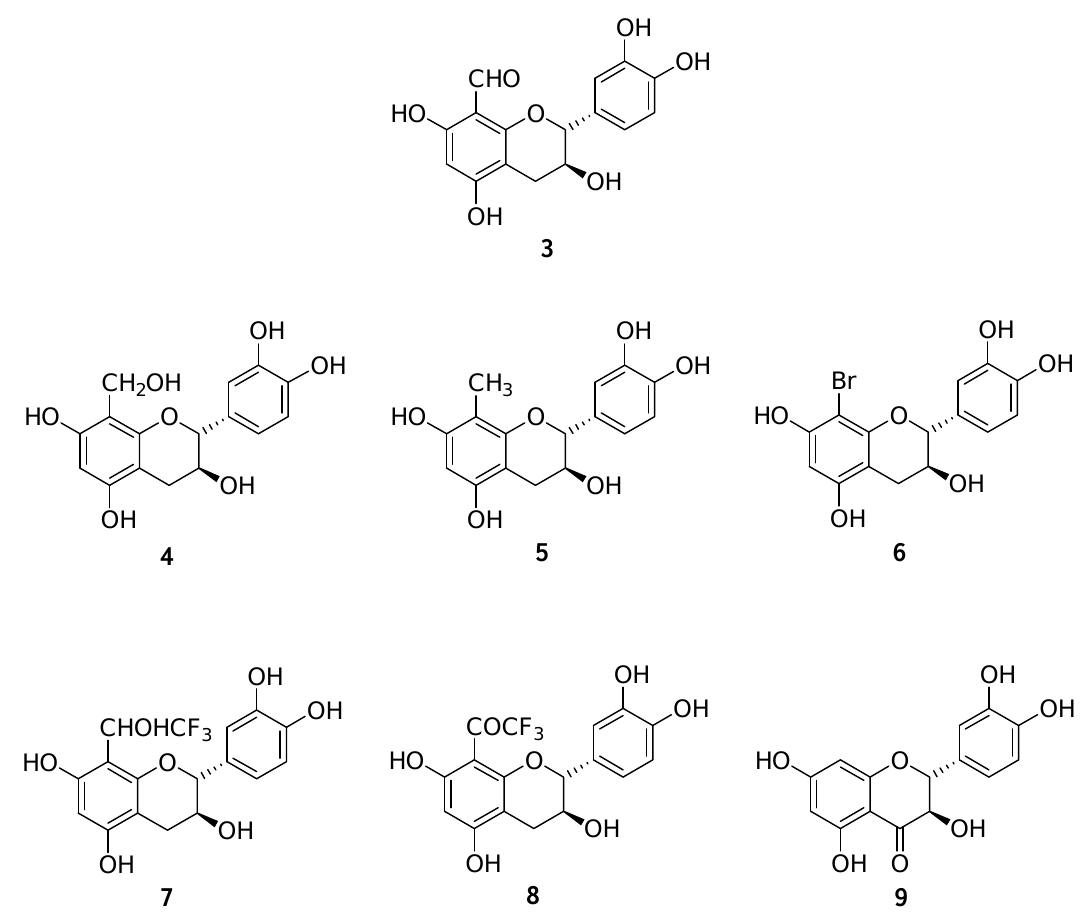
Figure 2. Structures of the studied modified flavan-3-ol monomers 3 - 9